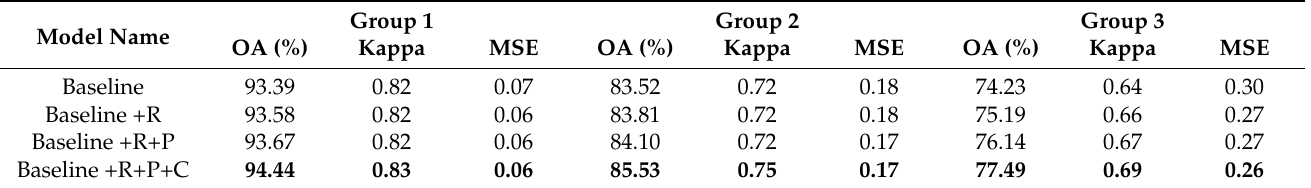
Table 8. The effects of different modules in EBDC-Net on the accuracy of building damage classifica- tion in the Ludian dataset.